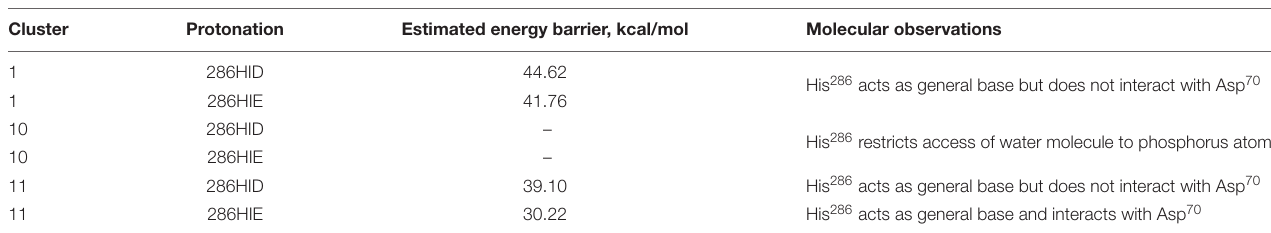
TABLE 3 | Results of QM/MM ranking analysis for BChE clone 15.